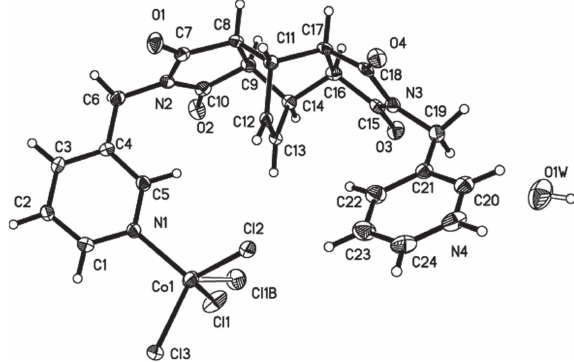
Table 1: Data collection and handling.